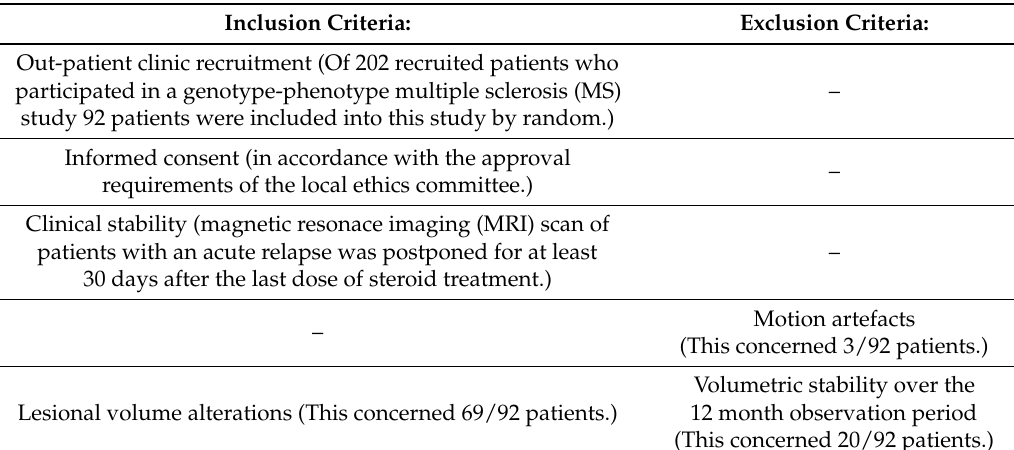
Table 3. Criteria for inclusion and exclusion of